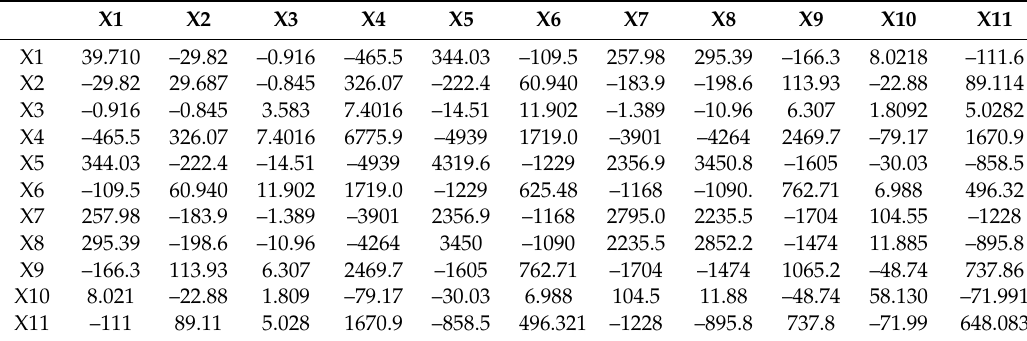
Table 6. Inverse of the correlation matrix of the healthy group (HG).